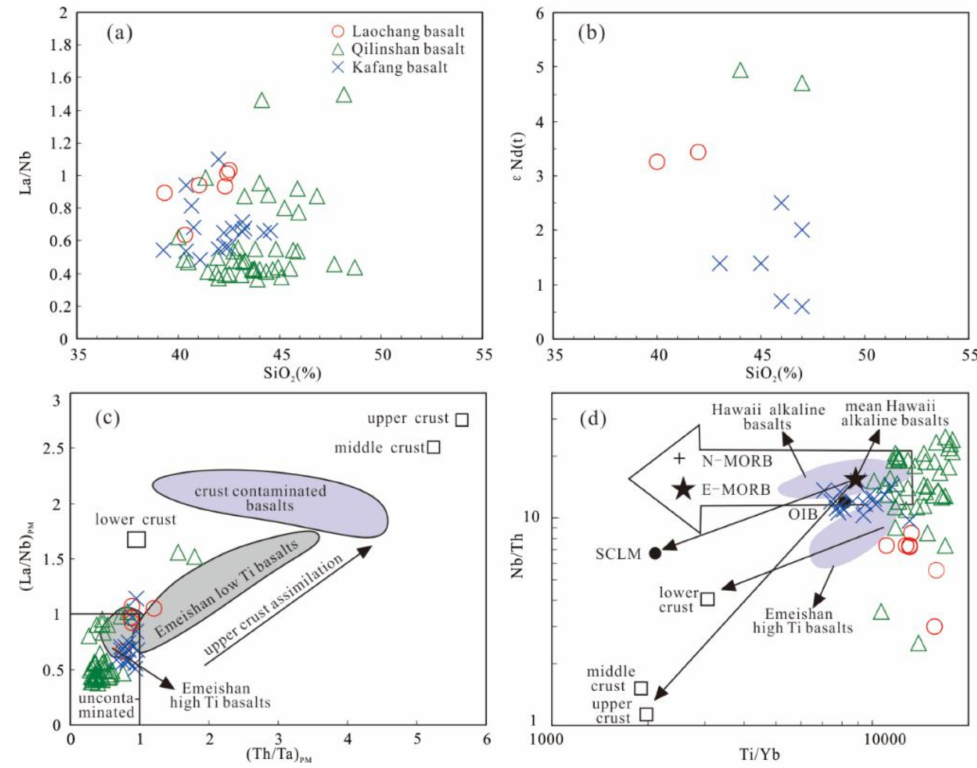
Figure 10. ( a ) SiO 2 vs. La / Nb diagram; ( b ) SiO 2 vs. ε Nd(t) diagram; ( c ) (Th / Ta) PM vs. (La / Nb) PM diagram (modified from [65]); ( d ) Ti / Yb vs. Nb / Th diagram (modified from [65]), N-MORB: